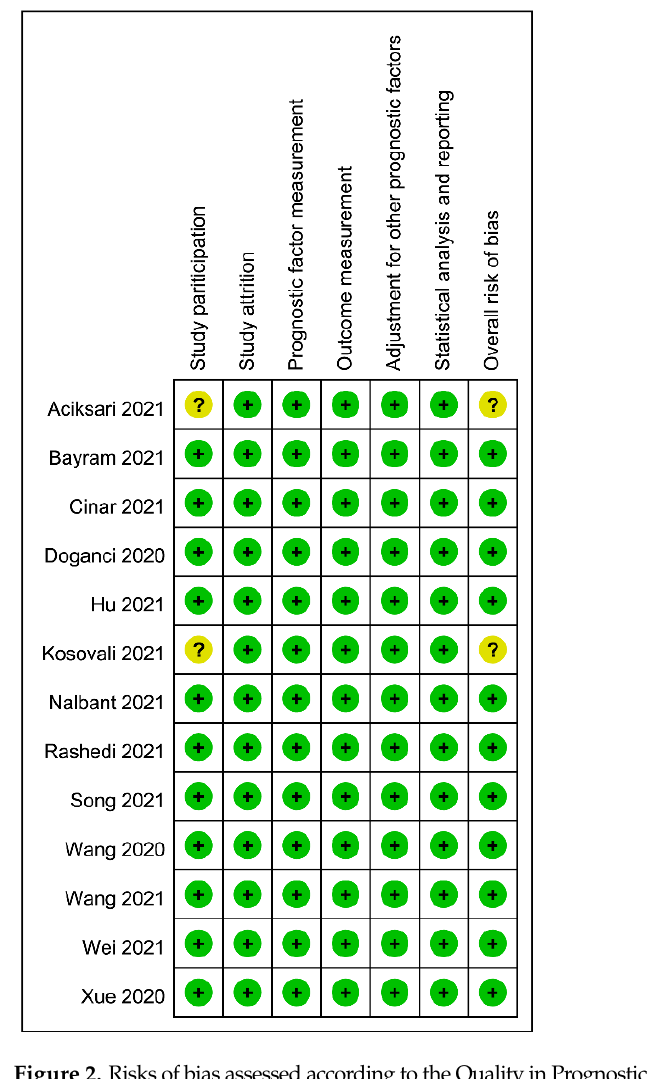
Figure 2. Risks of bias assessed according to the Quality in Prognostic Studies (QUIPS) tool [11,19–